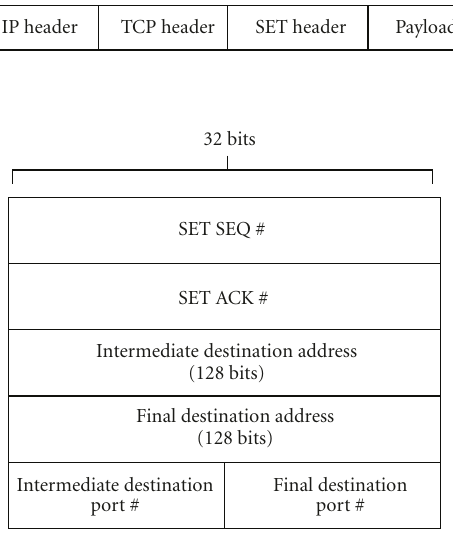
Figure 6: SET header